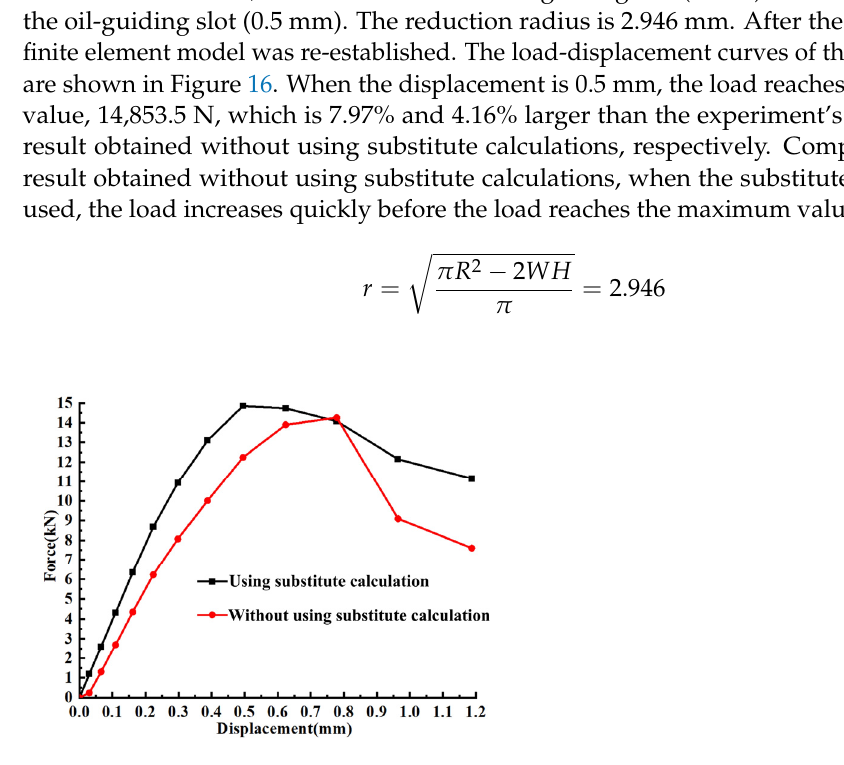
Figure 16. Load–displacement curves using substitute calculations.